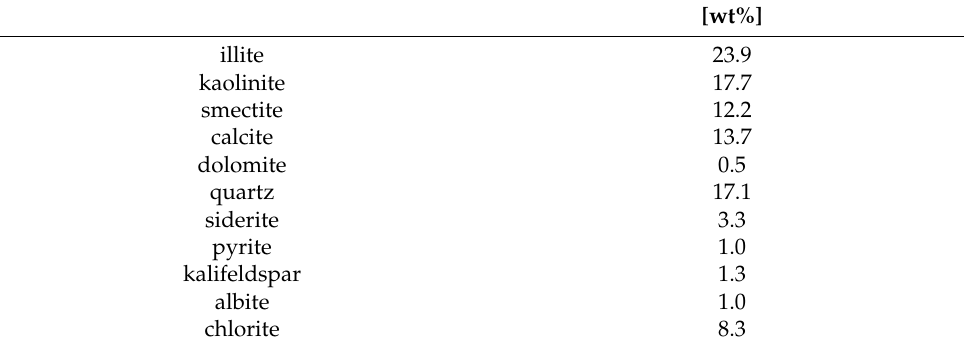
Table 3. Mineral composition of OPA in wt% of dry